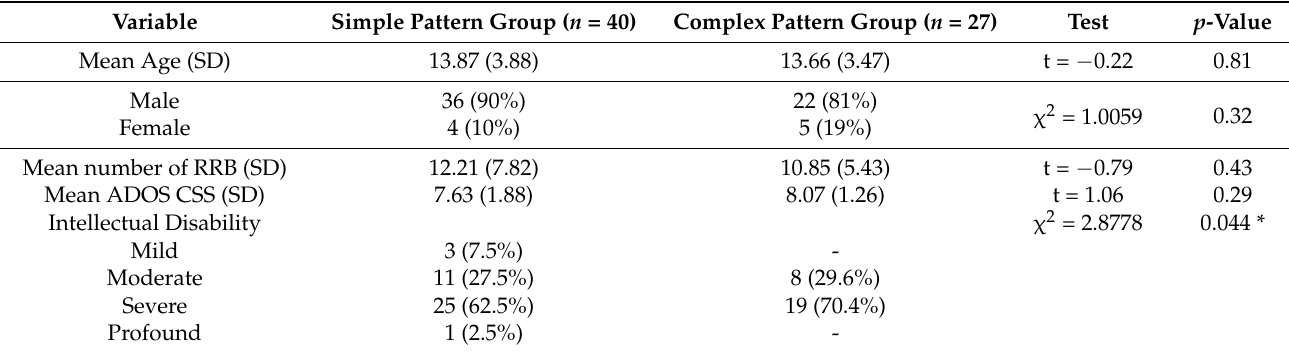
Table 5. Comparison between 40 subjects with a prevalent simple pattern of RRBs and 27 subjects with a prevalent complex pattern of RRBs.